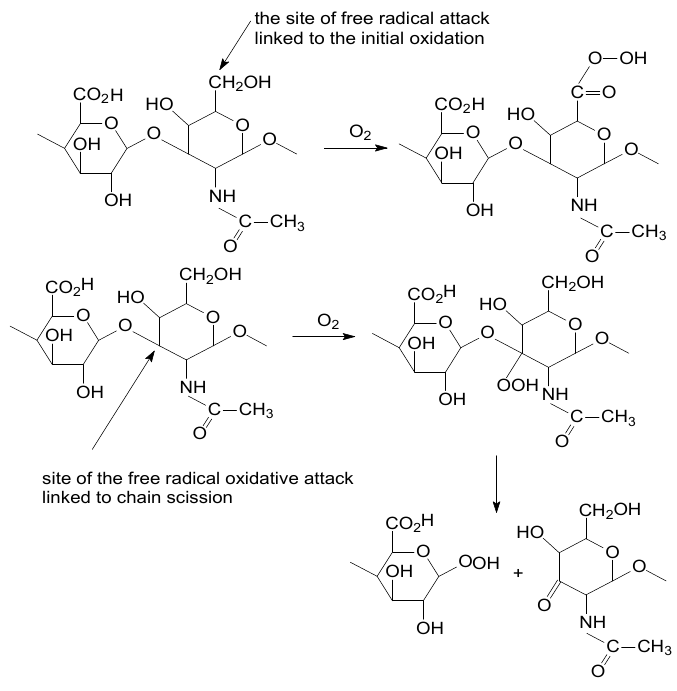
Scheme 3. The potential sites of the free-radical attack on